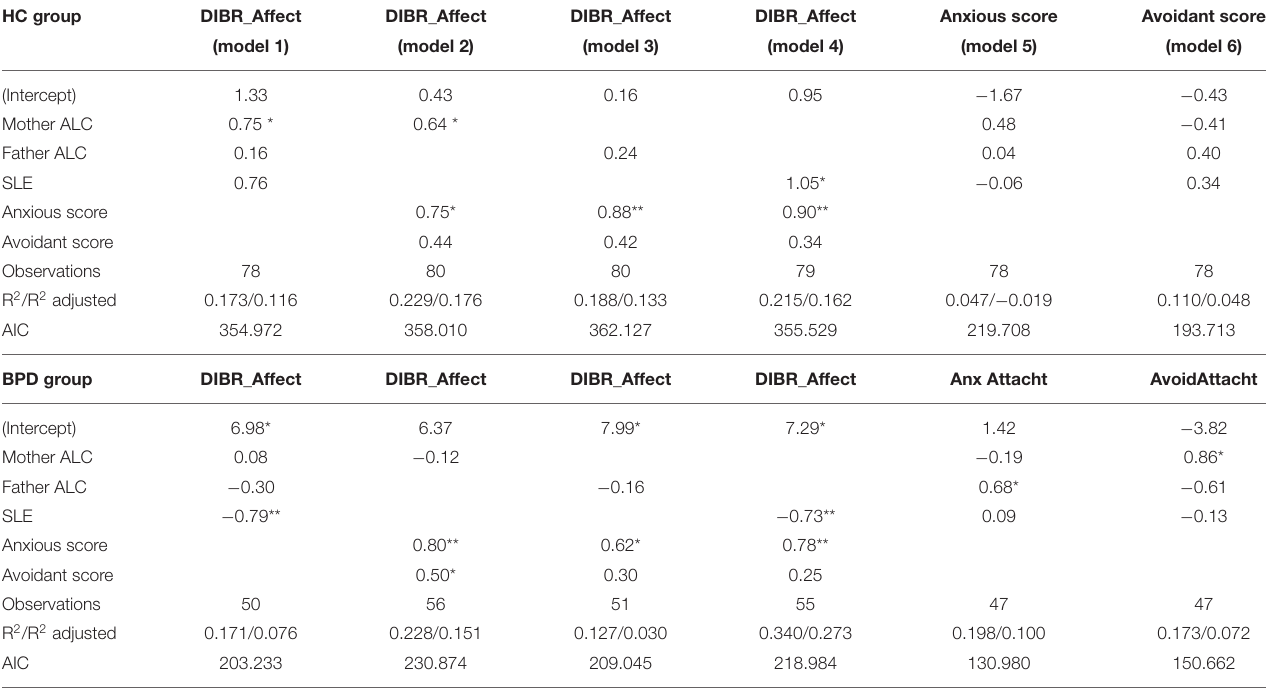
TABLE 4 | Multivariate regression model predicting the respective effects of maternal and paternal ALC and SLEs on affective symptoms and on attachment, in BPD and HC groups. HC